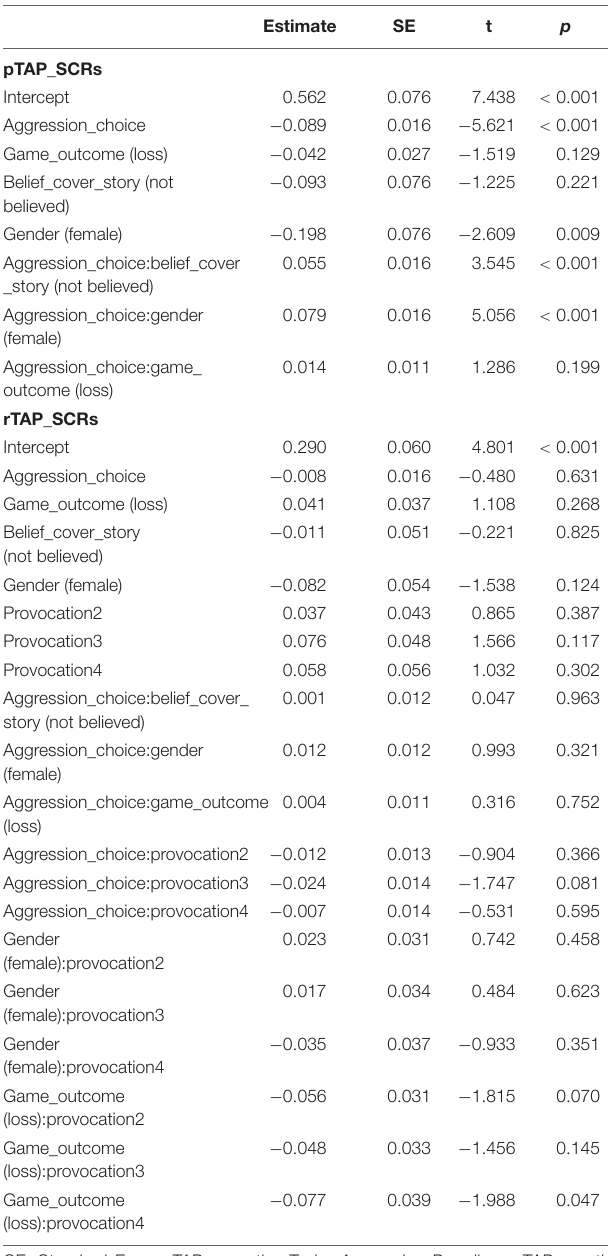
TABLE 3 | Parameter estimates and statistics of the generalized linear mixed-effects model analyses for skin conductance responses in the pTAP and